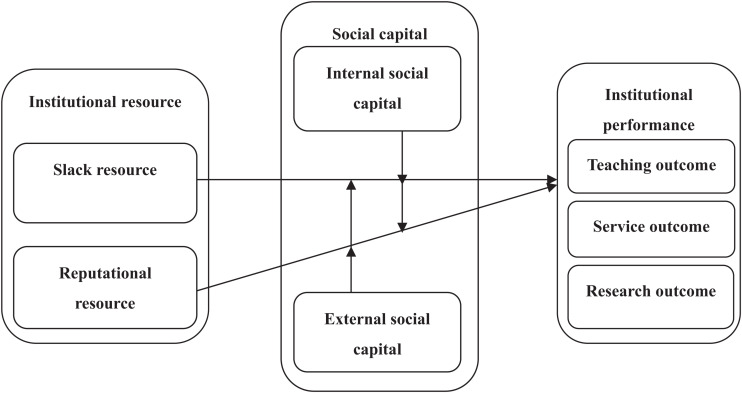
Research framework.